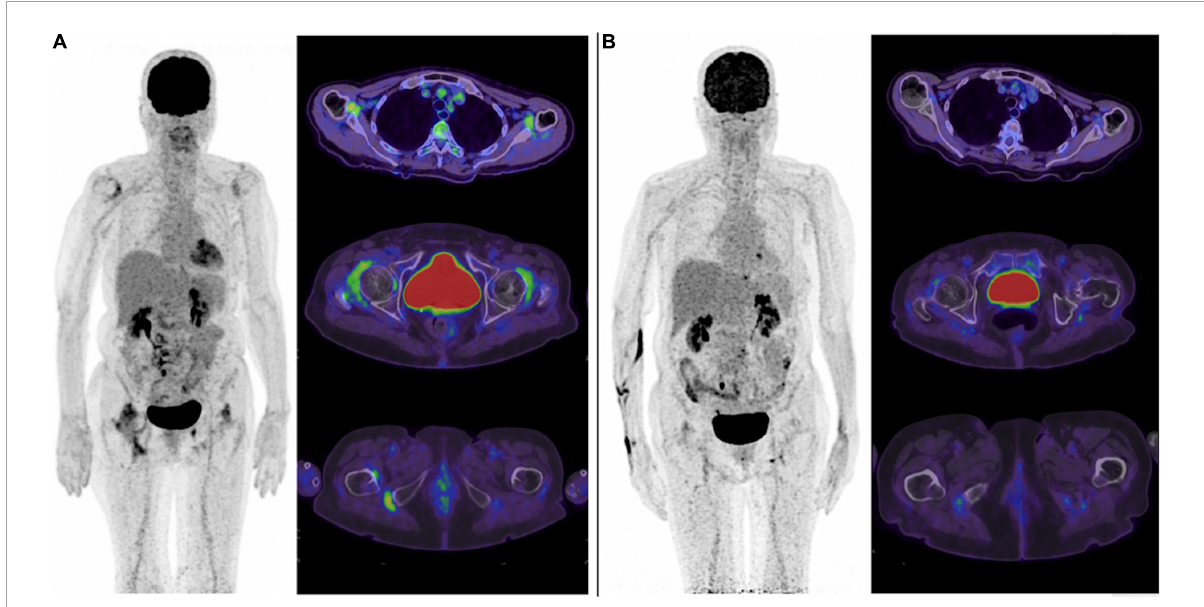
FIGURE4 18 F-FDG PET changes under treatment: typical but no current benefit over standard biomarkers. In this case of PMR, significant decrease of 18 F-FDG uptake is observed in the targeted joints (here the scapular and pelvic girdles, ischial tuberosities) under treatment (A) baseline scan, and (B) after several lines of treatment). Although metabolic changes assessed with 18 F-FDG are frequently observed, the clinical benefit of such imaging biomarker over standard clinical and biological biomarkers for disease monitoring remains to be